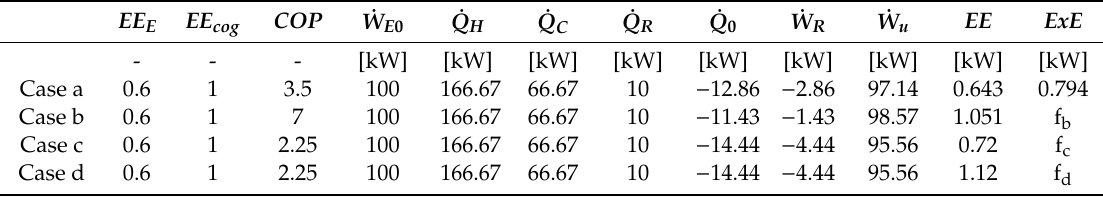
Table 2. Constant numerical results for the operational